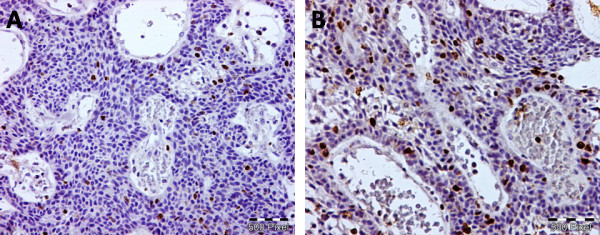
Nuclear KI67 immunostaining (A) represents Ki 67 labeling index reaching 7% of neoplastic cells. (B) represents Ki 67 index reaching 20% of neoplastic cells (immunoperoxidase X200).